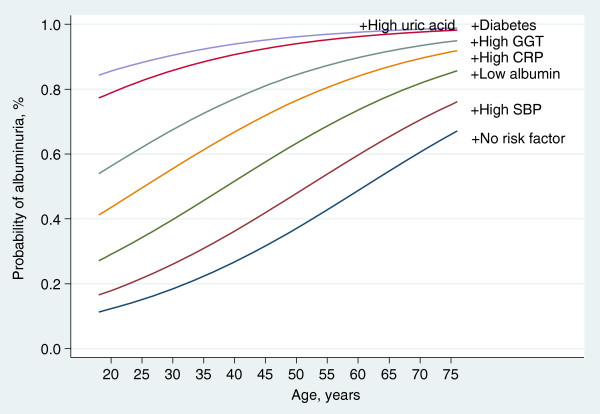
Predicted amplification of albuminuria by multiple risk factors.